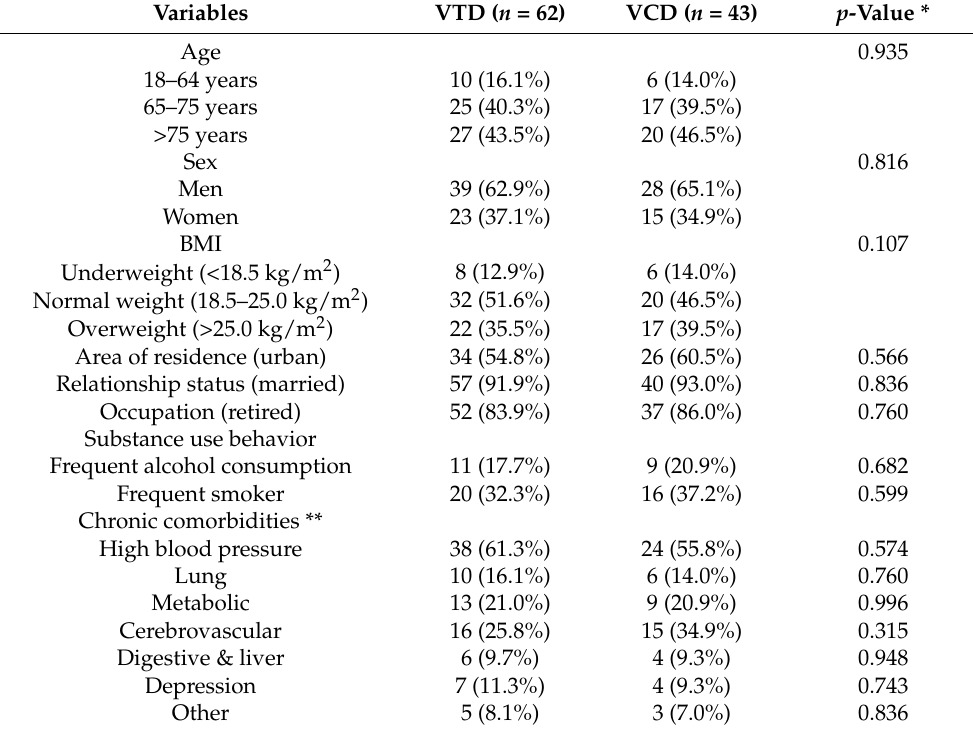
Table 1. Comparison of the study cohort background characteristics before pretransplant